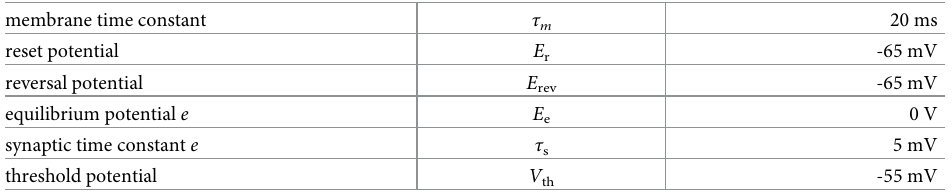
membrane time constant τ m 20 ms reset potential E r -65 mV reversal potential E rev -65 mV equilibrium potential e E e 0 V synaptic time constant e τ s 5 mV threshold potential V th -55